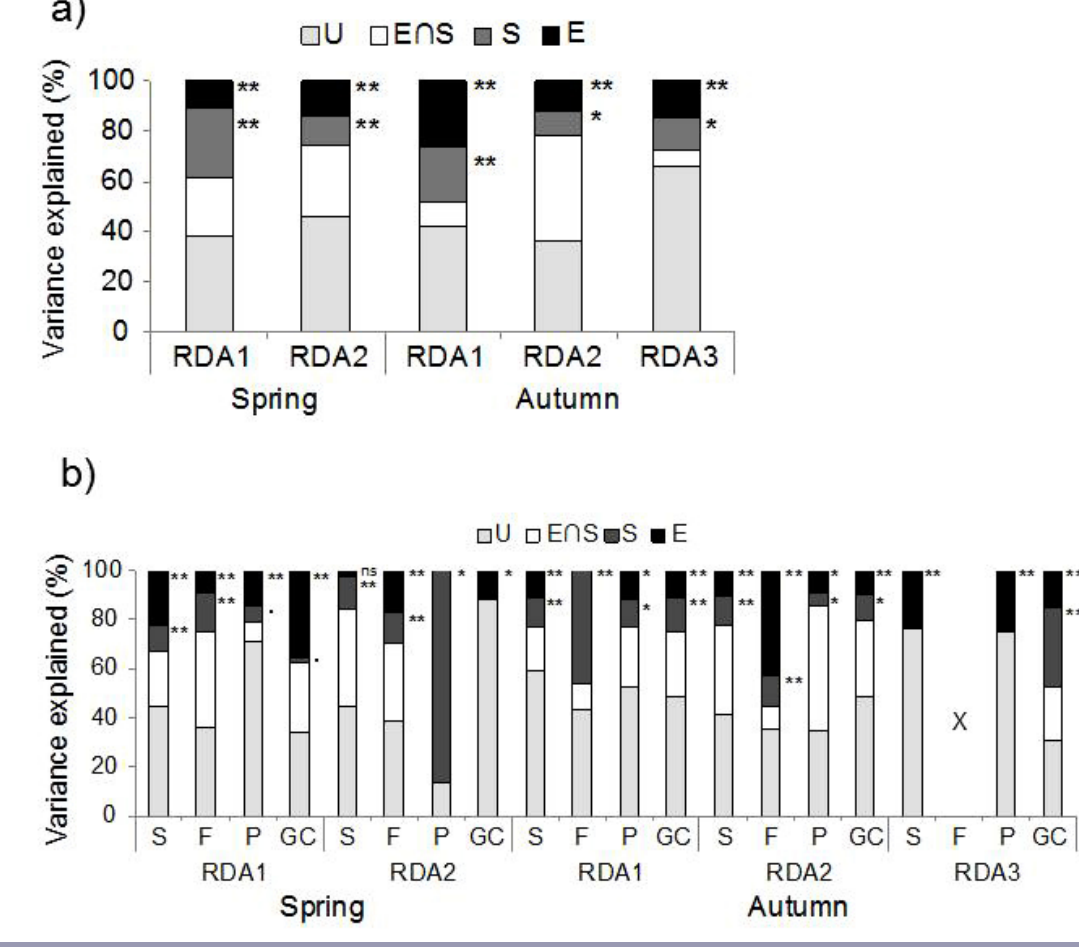
Fig. 4 . Results of the variance partitioning analyses. The figure shows the amount of variance in (a) functional composition and (b) taxonomic composition within each functional group explained (%) by local environmental factors (E) and spatial eigenvectors (S). Shown are also variances explained jointly by environmental and spatial factors (E!S) and unexplained variation (U). X indicates that no taxa were associated with that particular scale and functional feeding group. F, filterer collector; GC, gatherer collector; P, predator; S, shredder. The tests are divided by season (spring and autumn) and spatial scale (RDA1, RDA2, and RDA3). The level of significance is